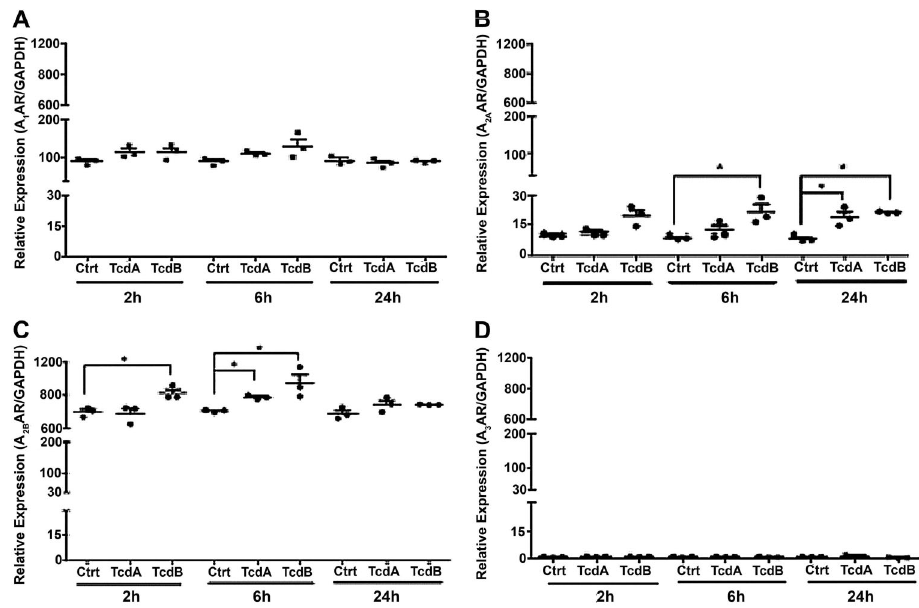
Figure 2. Effect of C. dif fi cile toxins on adenosine receptor (AR) expression in vitro . HCT-8 cells were intoxicated with TcdA or TcdB (10 ng/mL) for 2, 6, and 24 h. Analyses of A 1 AR ( A ), A 2A AR ( B ), A 2B AR ( C ), and A 3 AR ( D ) mRNA expression were performed by qPCR. Each assay was performed in triplicate per time-point. *P o 0.05 compared with control (Ctrl) (one-way ANOVA with Bonferroni post- test). Vertical lines indicate mean ±